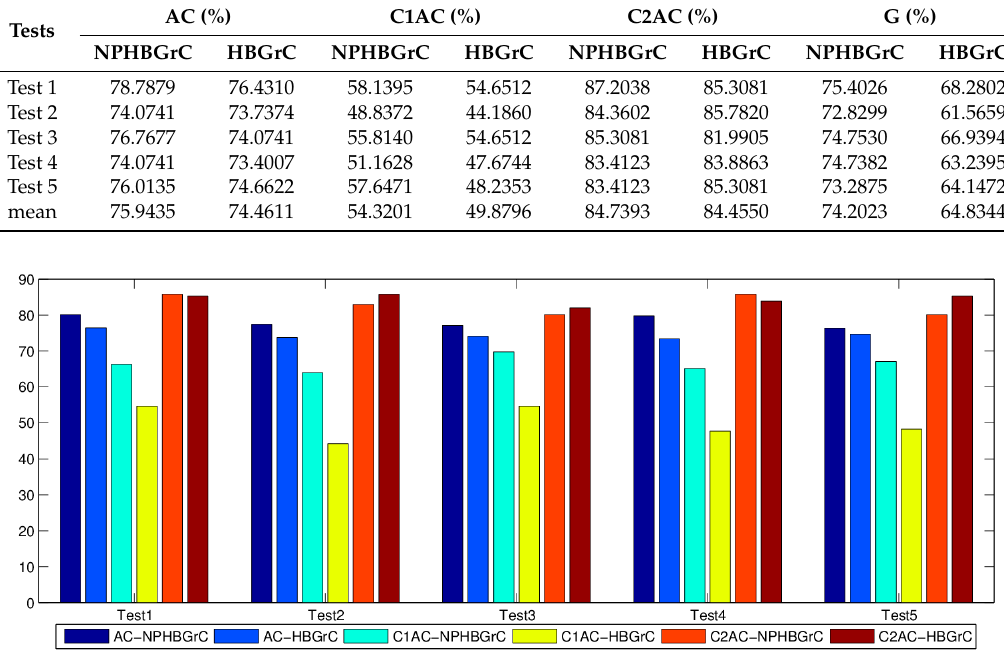
Table 5. Performance of NPHBGrC and HBGrC for the imbalanced dataset “yeast”.